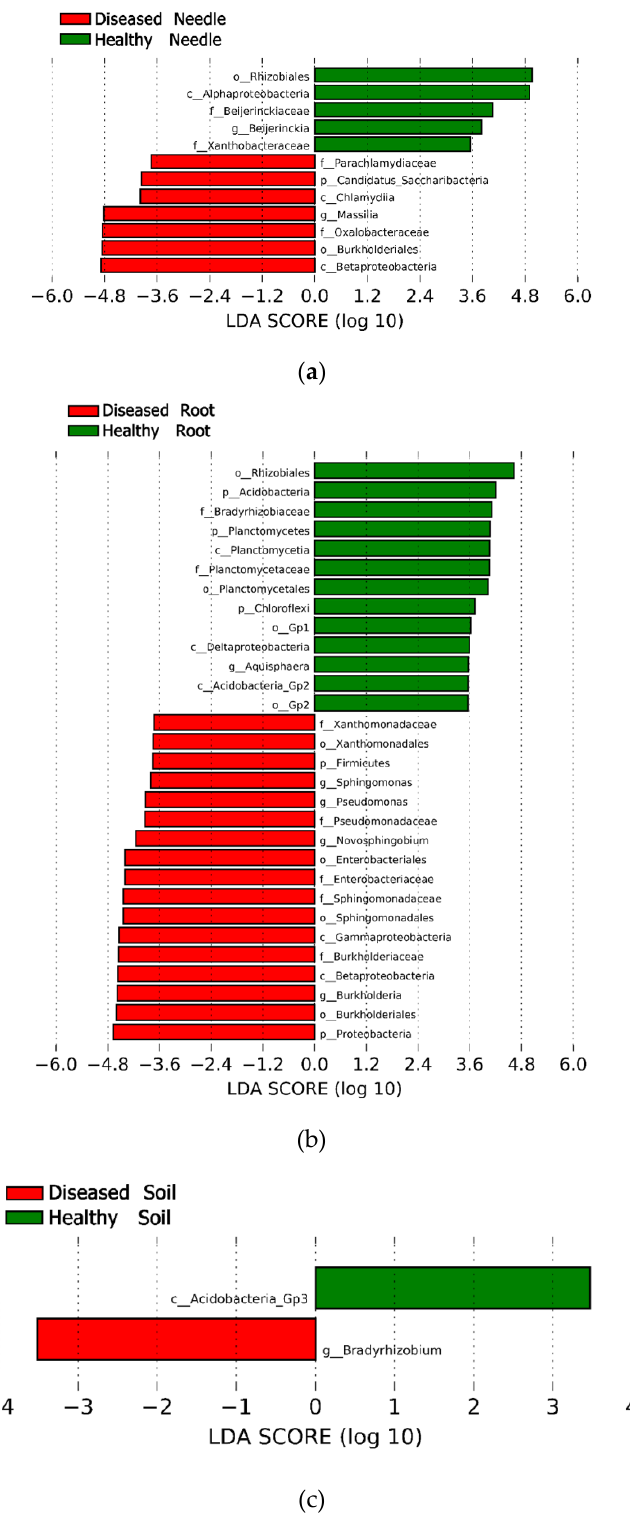
Figure 2. Lefse analysis showing the significant di ff erences at di ff erent bacterial taxonomic levels between diseased and healthy samples in the needles ( a ), roots ( b ), and soil ( c ). Abbreviation: p: phylum, c: class, f: family, o: order, and g: genus.